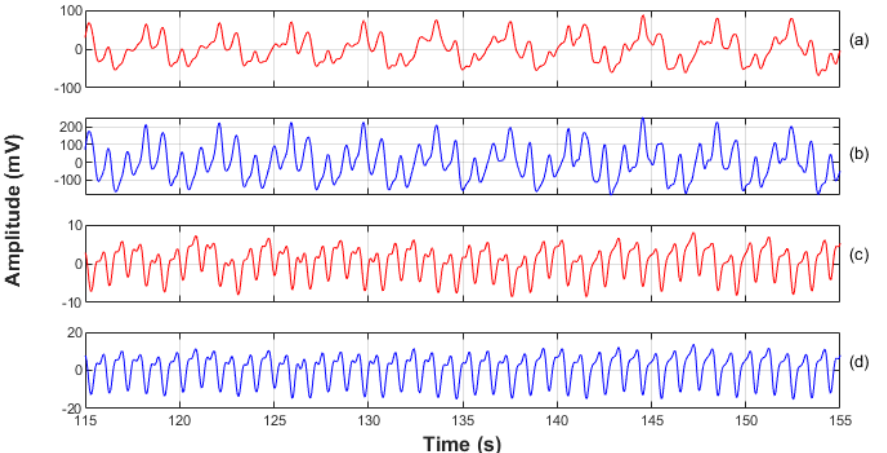
Figure 4. A 40 s sample of normalised PPG signals. For illustrative purposes the DC component, and high frequency noise have been filtered out. ( a ) The red PPG signal from the ET sensor. ( b ) The infrared signal from the ET sensor. ( c ) The red signal from the periphery sensor. ( d ) The infrared signal from the periphery sensor. It can be seen that all signals show a periodic modulation; this was caused by the ventilator and was removed with a high pass filter prior to signal analysis and vital-sign computations.